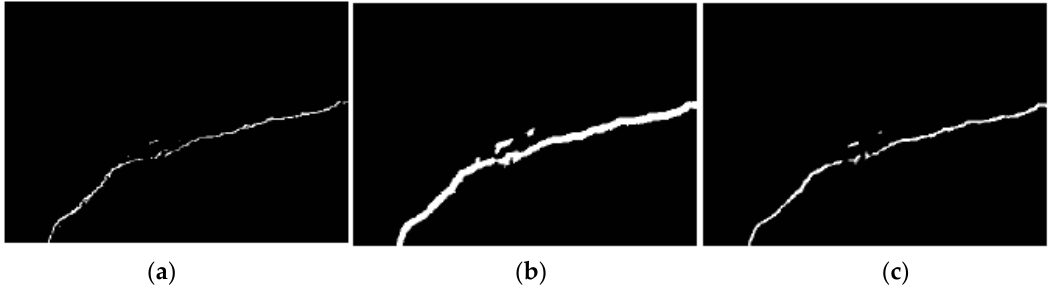
Figure 6. Crack-locating results compared of different sampling processes: ( a ) The ground-truths labeled manually; ( b ) detection result of uniform sampling; ( c ) detection result of uniform sampling with nearest neighbors.